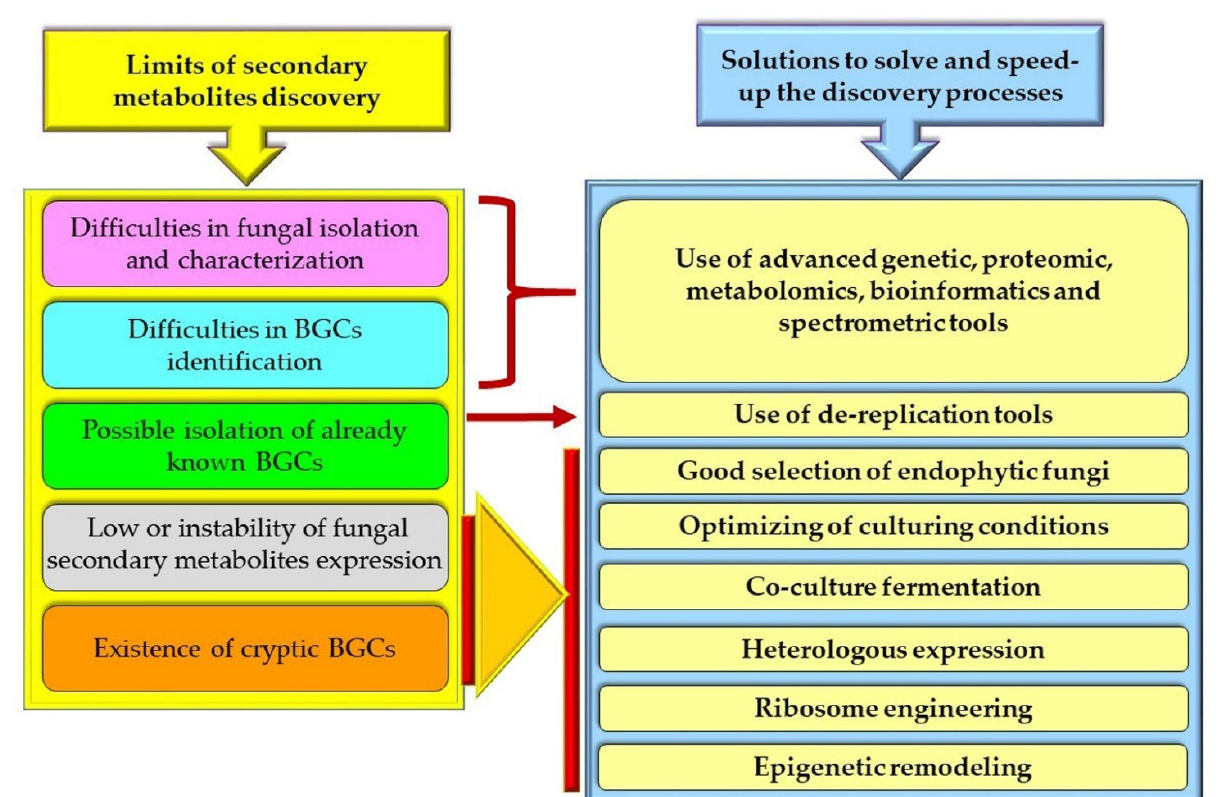
Figure 3. Limits and solutions helping in novel secondary metabolite discoveries.